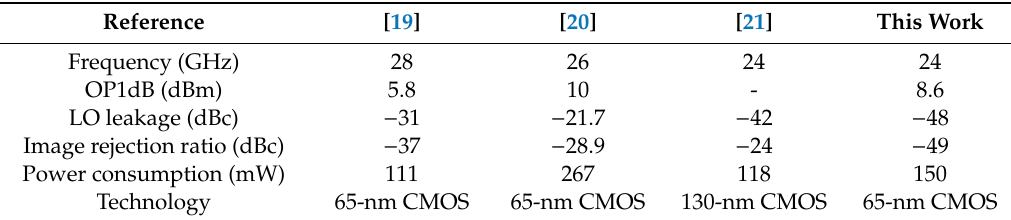
Figure 12. ( a ) Measured output power at RF output frequency of 24 GHz, ( b ) measured output spectrum at 5 dBm of desired RF signal output. (IF frequency used was 10 MHz).